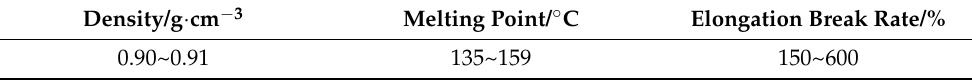
Table 3. Basic indicators of recycled PP pellets.